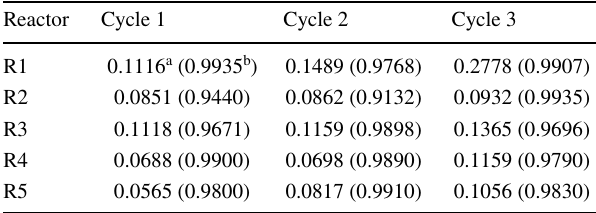
Table 6 The reaction rate constant and the regression coefficient for the successive cycles